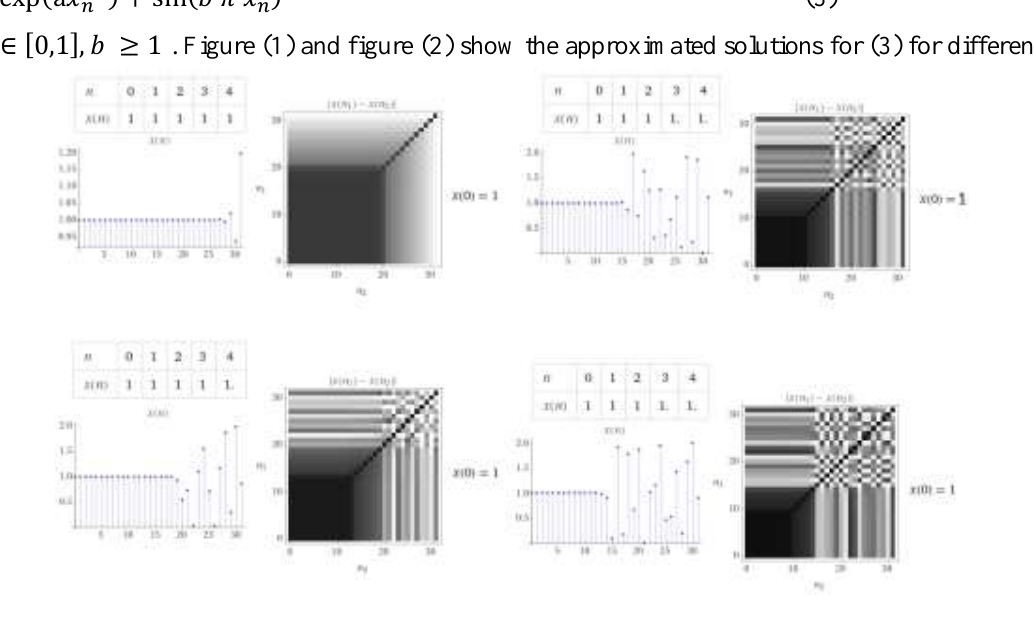
Figure 1 . The discrete plotting of Eq.(3) when a=0 and for b=1,…,4 respectively. All values of x